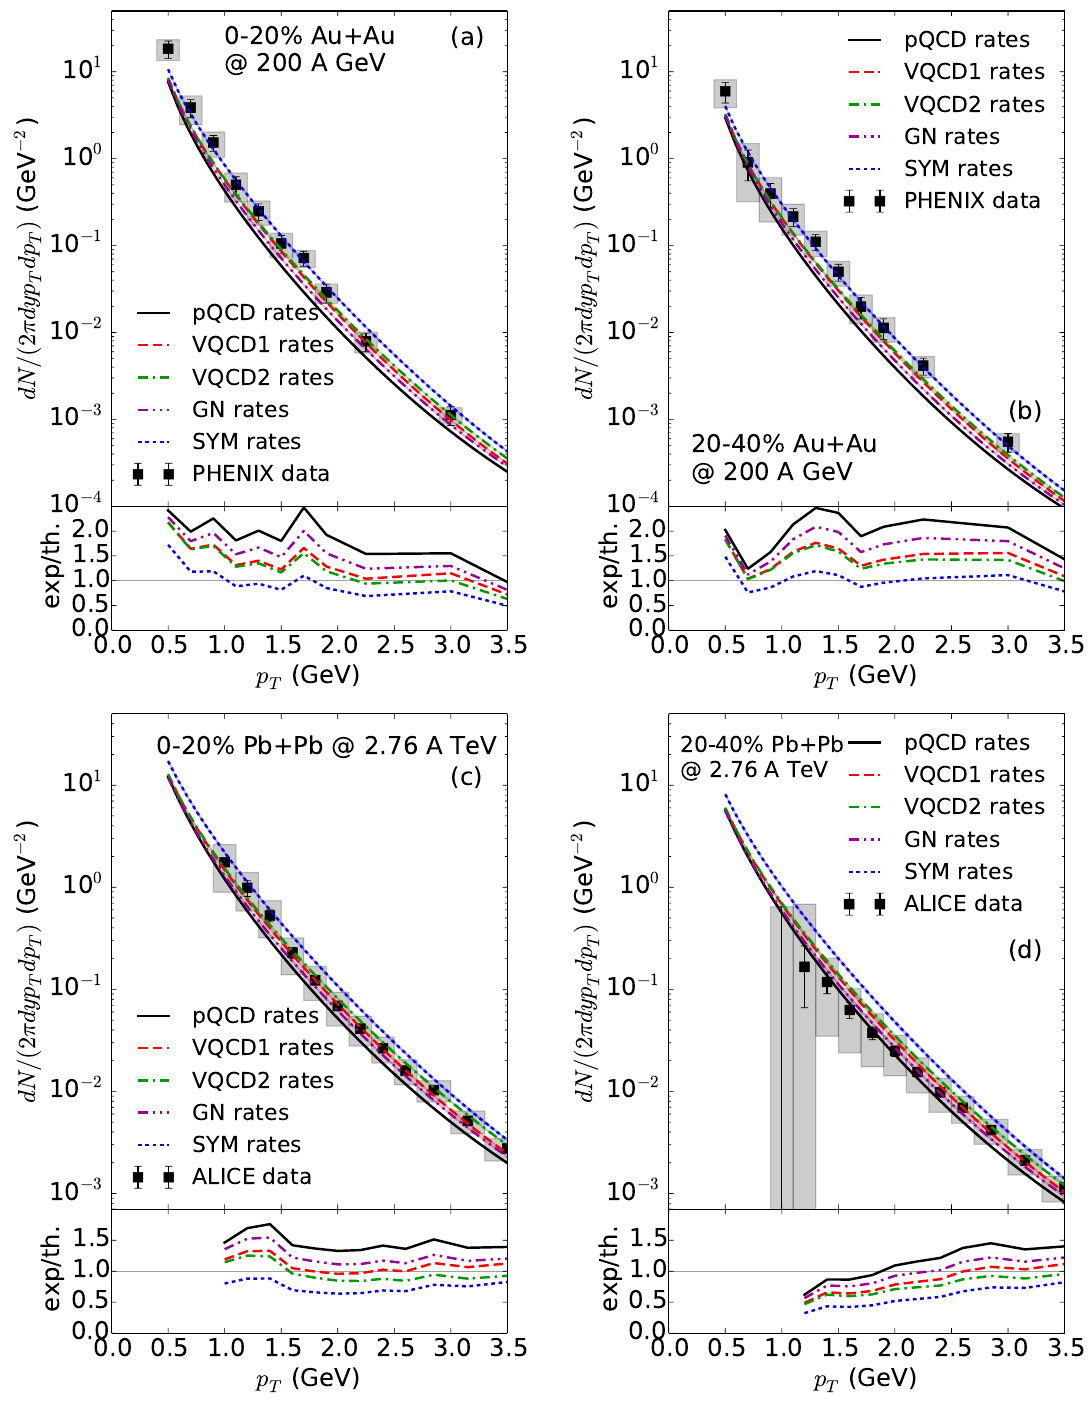
Figure 3 . (Color online) Direct photon spectra from 0{20% (a) and 20{40% (b) Au+Au collisions at 200 GeV compared with the PHENIX measurements [95] and from 0{20% (c) and 20{40% (d) Pb+Pb collisions at 2.76 A TeV compared with the ALICE measurements [96]. The ratios of experimental data to theoretical results are shown in the bottom of each plot.